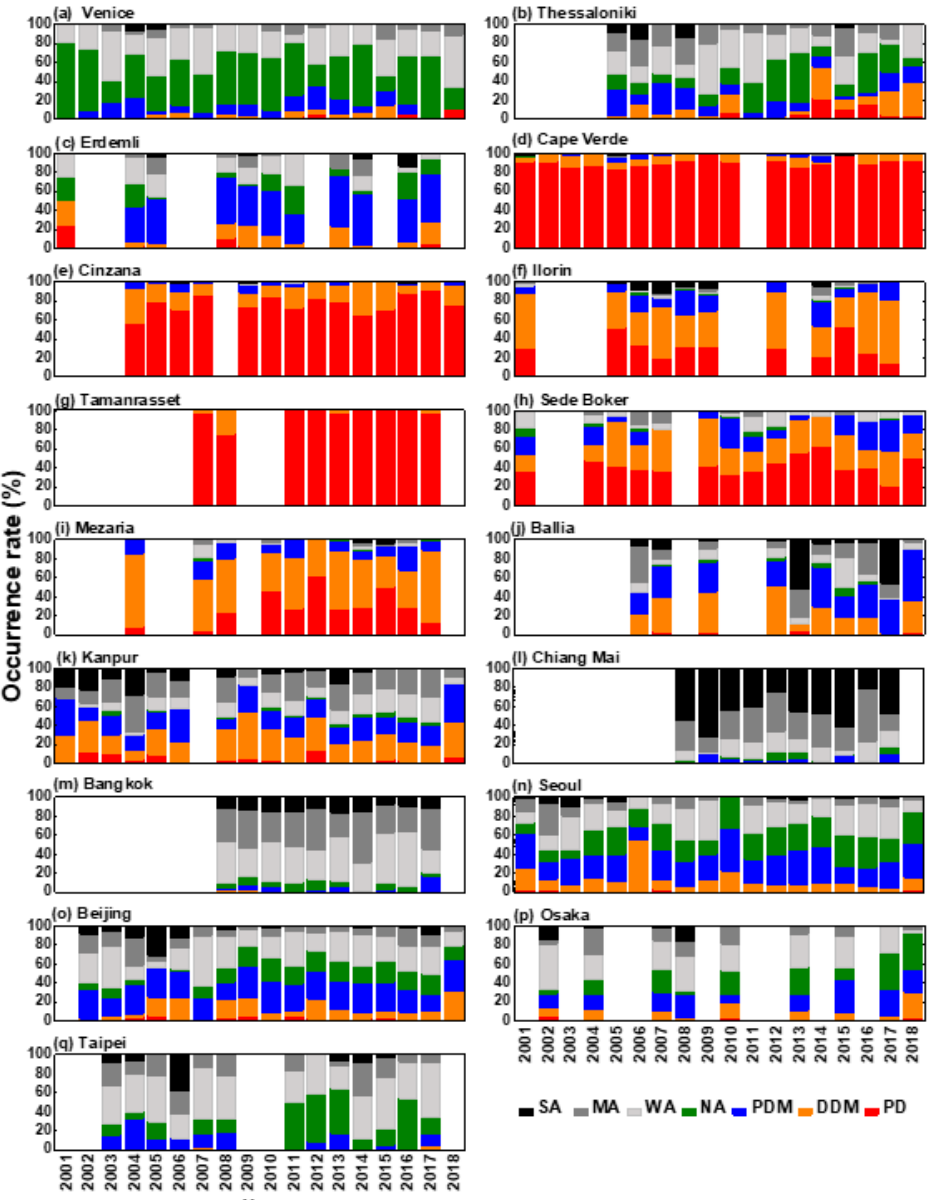
Figure 2. Aerosol type classification expressed in terms of PD (pure dust), DDM (dust dominant mixture), PDM (pollution dominant mixture), and pollution aerosols, and classified in terms of NA (non-absorbing), WA (weakly absorbing), MA (moderately absorbing), and SA (strongly absorbing).